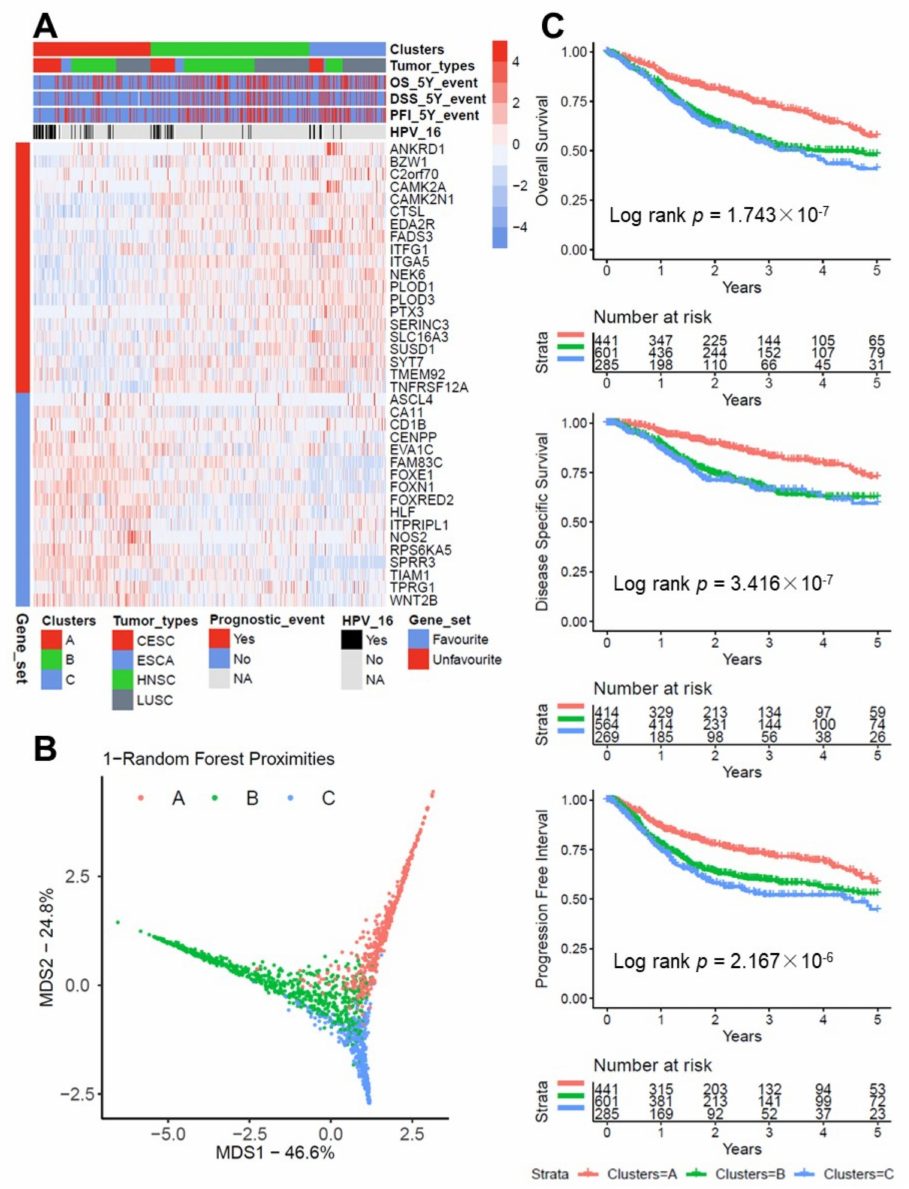
Figure 1. Establishment of a prognostic pan-SCC classifier based on survival-related candidate genes. ( A ) Heatmap illustrates classification of pan-SCC cases by k-means clustering based on a distance matrix calculation from the resampled expression data of indicated candidate genes. Rows and columns indicate candidate genes and cases, respectively. ( B ) Random forest MDS plot presents distinct features of clusters based on 37 survival-related candidate genes for the pan-SCC cohort. ( C ) Kaplan–Meier plots for five-years OS (top), DSS (middle), and PFI (bottom) of the three clusters for the pan-SCC cohort. p -values were computed by the log-rank test and numbers represent cases at risk at the indicated time